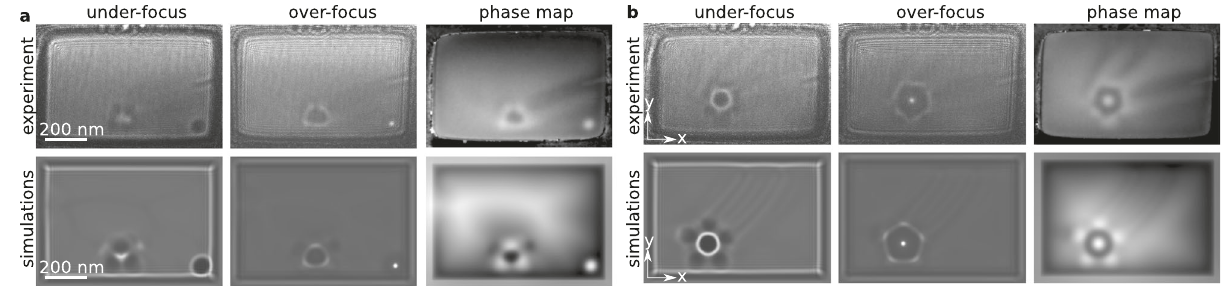
Fig. 4 Comparison between experimental and simulated images of skyrmion braids. a , b Magnetic images of skyrmion braids containing three and six skyrmion strings, respectively. The upper panel shows experimental underfocus and overfocus Lorentz TEM images and electron optical phase-shift images recorded using off-axis electron holography from sample S2 at 95 K. The lower panel shows the corresponding simulated Lorentz TEM images and phase- shift images. The perpendicular applied magnetic fi eld in a and b is 218 and 187 mT, respectively. The high-contrast feature at the lower-right corner in a is an isolated skyrmion string attached to the edge. The sample size, external magnetic fi eld, defocus and accelerating voltage are the same for the experimental and